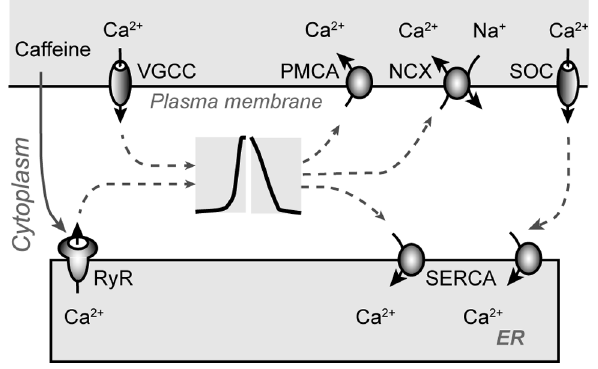
Figure 6. Schematic illustration of Ca 2 + pathways relevant to the caffeine-induced [Ca 2 + ] i oscillations in carp retinal HCs. SOC: store-operated channel; VGCC: voltage-gated Ca 2 + channel; PMCA: plasma membrane Ca 2 + -ATPase; NCX: Na + /Ca 2 + exchanger; RyR: ryanodine receptor; SERCA: sarco/endoplasmic reticulum Ca 2 + -ATPase; ER: endoplasmic reticulum.